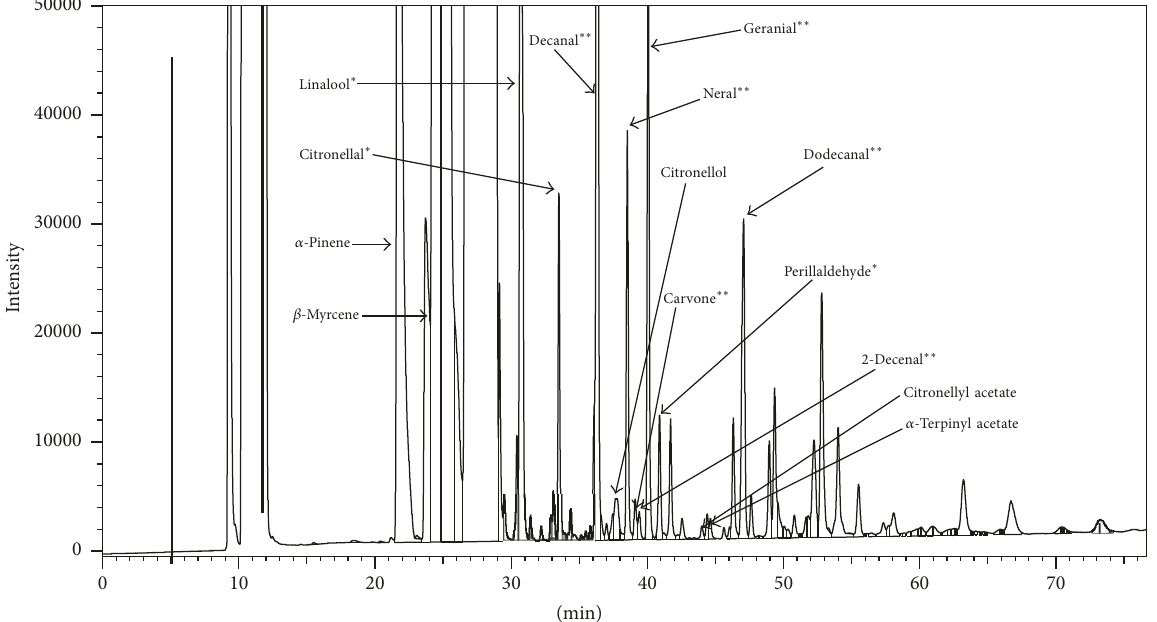
Figure 7: Chromatogram from Valencia Late Asymptomatic. Note . While 2,4-decadienal was quantifiable in this sample, it was not labeled on the chromatogram as the peak is too small to be seen. ∗ Compound has lower concentration compared to VLS. ∗∗ Compound has higher concentration compared to